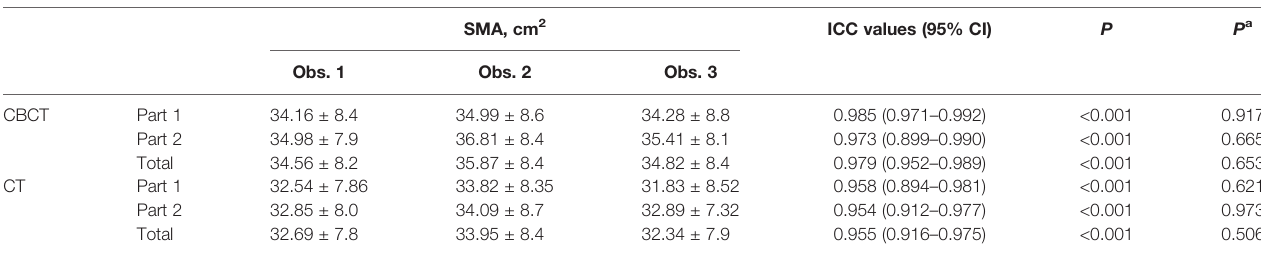
TABLE 2 | SMA measurement at the level of C3 on CT and